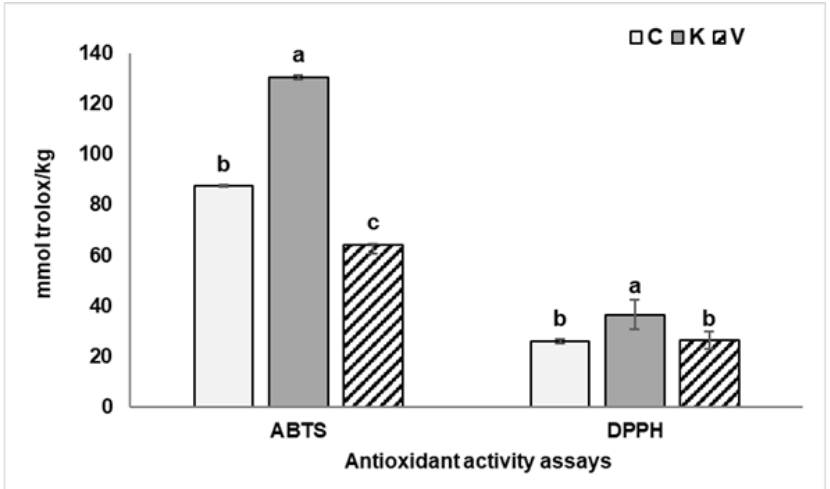
Figure 5. Effect of kaolin (K) and 1-p-menthene (V) on antioxidant activity (ABTS and DPPH) in leaves olive trees at the end of growing season. C: control. Vertical bars indicate ± SE (standard error) of the means. Different letters indicate significant differences according to Duncan’s multiple-range test ( p = 0.05).